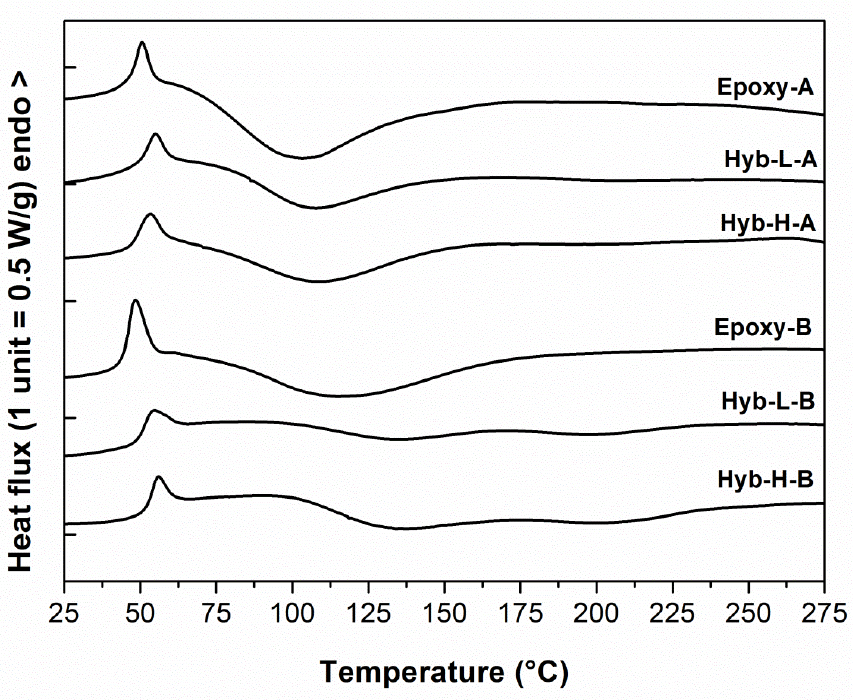
Figure 4. Dynamic DSC thermograms at 10 °C/min of hybrid and non-hybrid epoxy systems cured for 7 days at room temperature as a function of DES content and curing agent typology.